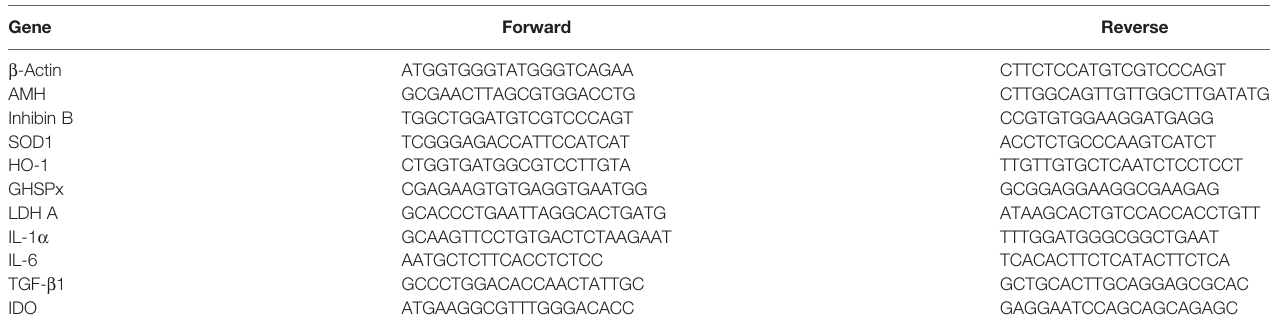
TABLE 1 | Primer sequences for PCR